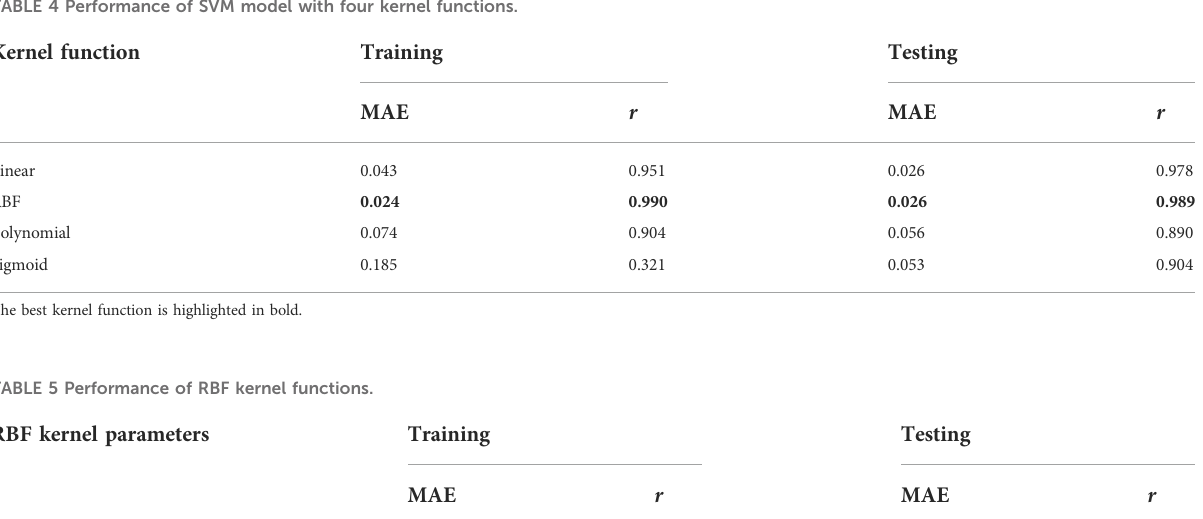
TABLE 4 Performance of SVM model with four kernel functions.